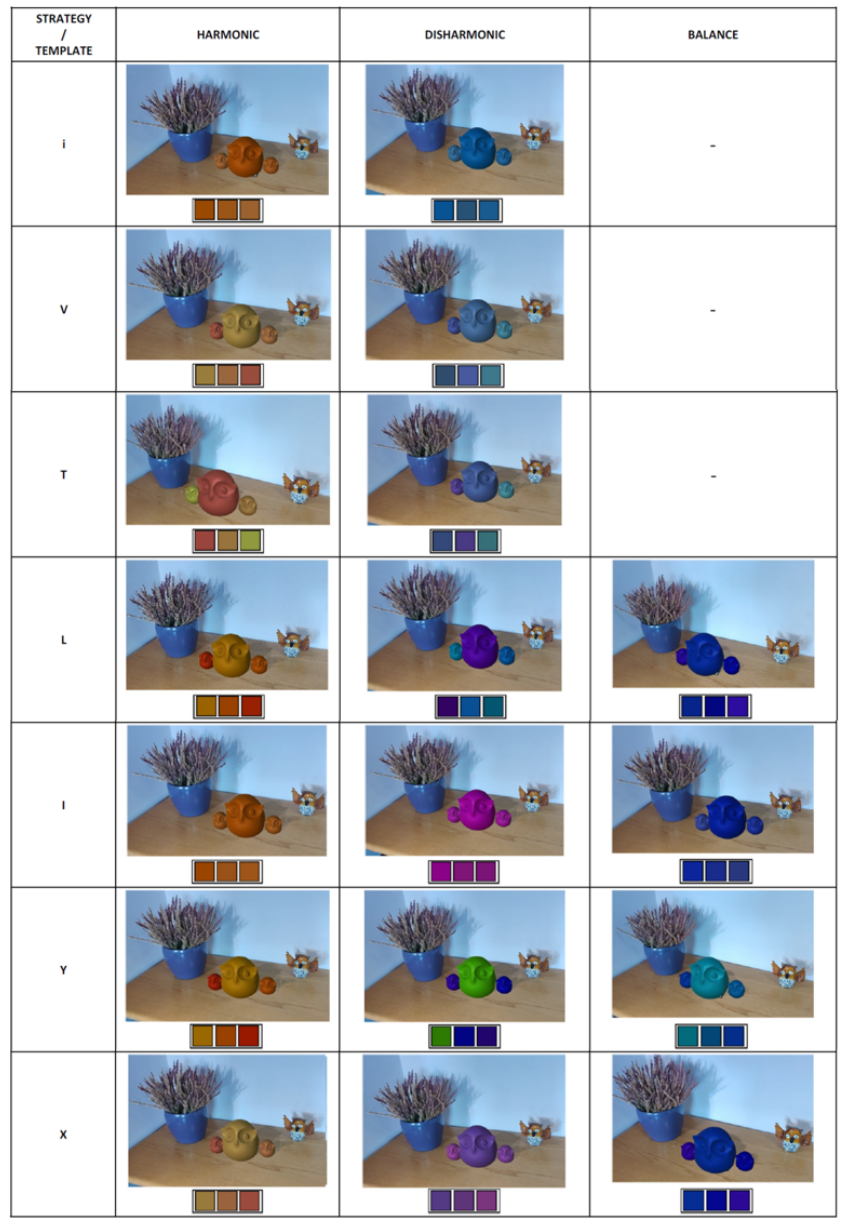
Figure 6. Recolored porcelain owl family by applying all templates and the three strategies. Different from the harmonic approach, the application of the disharmonic strategy produces discordant colors with respect to the real background. Blue, violet, and green colors are generated and applied to the virtual objects. By using the last approach, instead, L and I templates generates shades of blue and violet. By applying the Y template, instead, shades of light blue are obtained. The adoption of the X template proposes blue color and shades of violet. As previously mentioned, it has been also considered the recolor- ing of a porcelain rabbit family placed on a living-room furniture. Figure 7 depicts an example of the recolored virtual objects obtained by applying the Y template and the three proposed